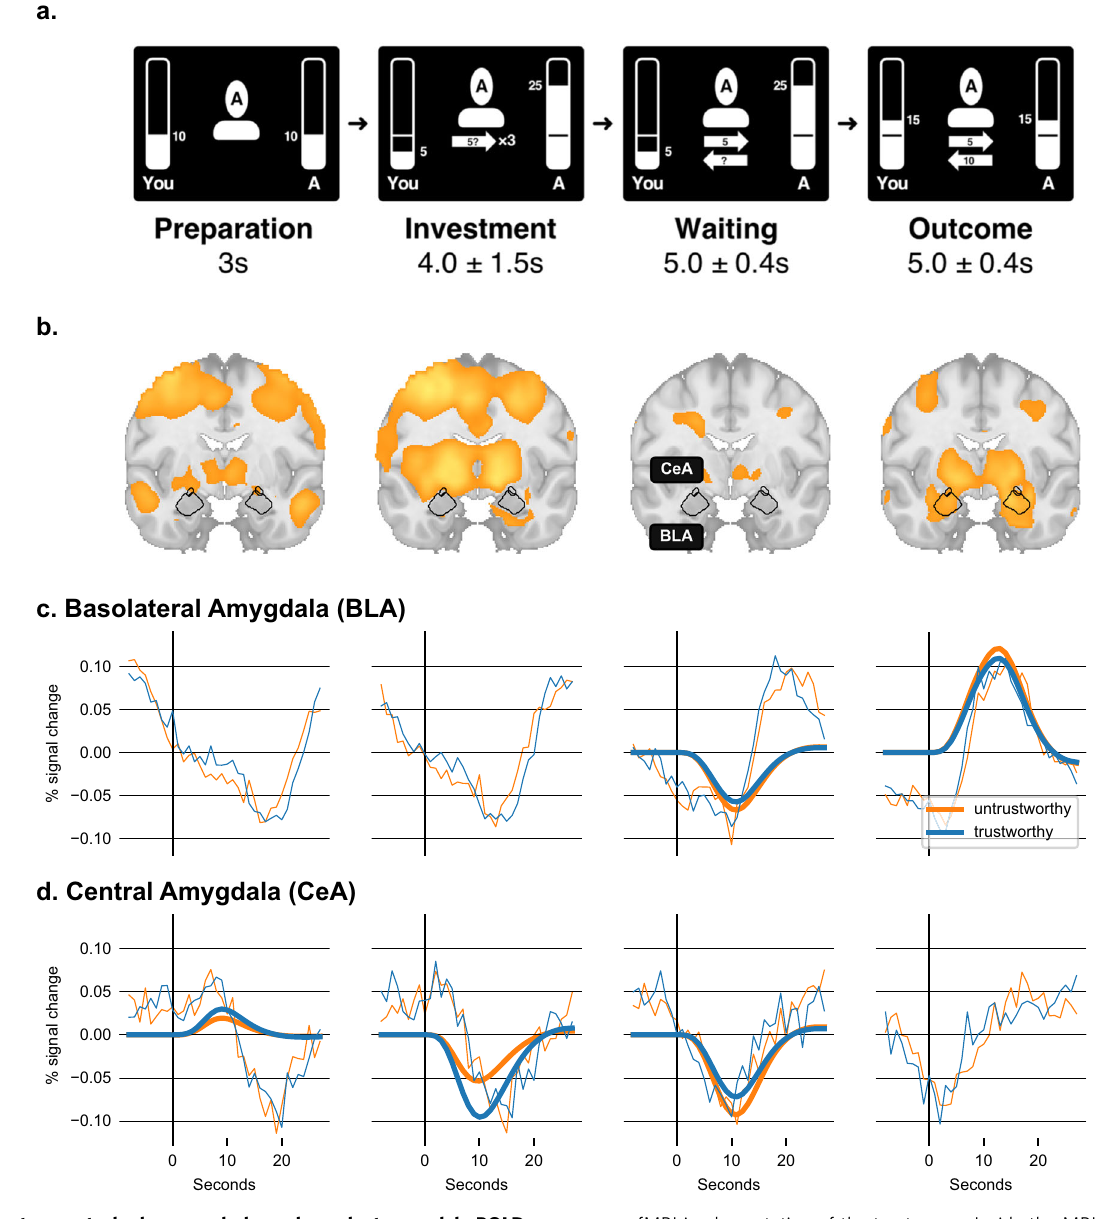
Fig. 2 Trust game task phases and phase-dependent amygdala BOLD response. a fMRI implementation of the trust game. Inside the MRI scanner, participants played the repeated trust game alternating with a (simulated) trustworthy and an untrustworthy player (2 × 20 rounds). Preparation Phase . Participants were presented with the face of the player they played with in this round. Both received an endowment of 10 points at the outset of each round. Investment Phase . Participants were asked to select an amount of 1 to 10 points to invest in the present player. The amount invested was tripled and added to the player ’ s account. Waiting Phase . While the players made their decision, the participant needed to wait. Outcome Phase . Finally, the player transferred back points to the participant, resulting in a non-negative outcome for the trustworthy (as shown in the example) and a non-positive outcome for the untrustworthy player. b Statistical parametric maps (SPMs) and outline of the anatomically de fi ned Volumes of Interest (VOIs) of BLA and CeA. SPMs show contrast for both players combined vs. baseline and are thresholded at p < 0.001 for display purposes. c , d Time course of BLA and CeA BOLD responses. CeA but not BLA was activated during the preparation phase, while BLA but not CeA was activated during the outcome phase. There were no activation differences between the trustworthy player (blue) and the untrustworthy player (orange). Thick lines represent the estimated BOLD response from the same SPM model shown in panel B (not shown if p > 0.05 Bonferroni corrected) and fi ne lines represent the actual data (average VOI time